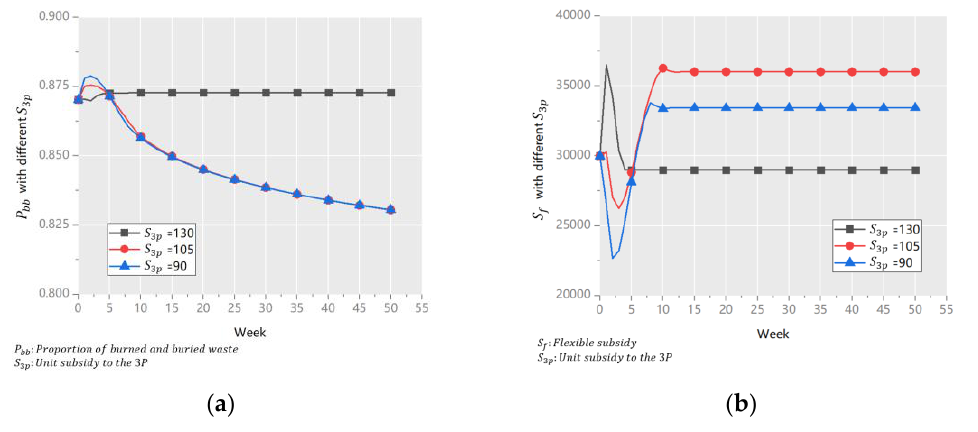
Figure 8. P bb ( a ) and S f ( b ) with different S